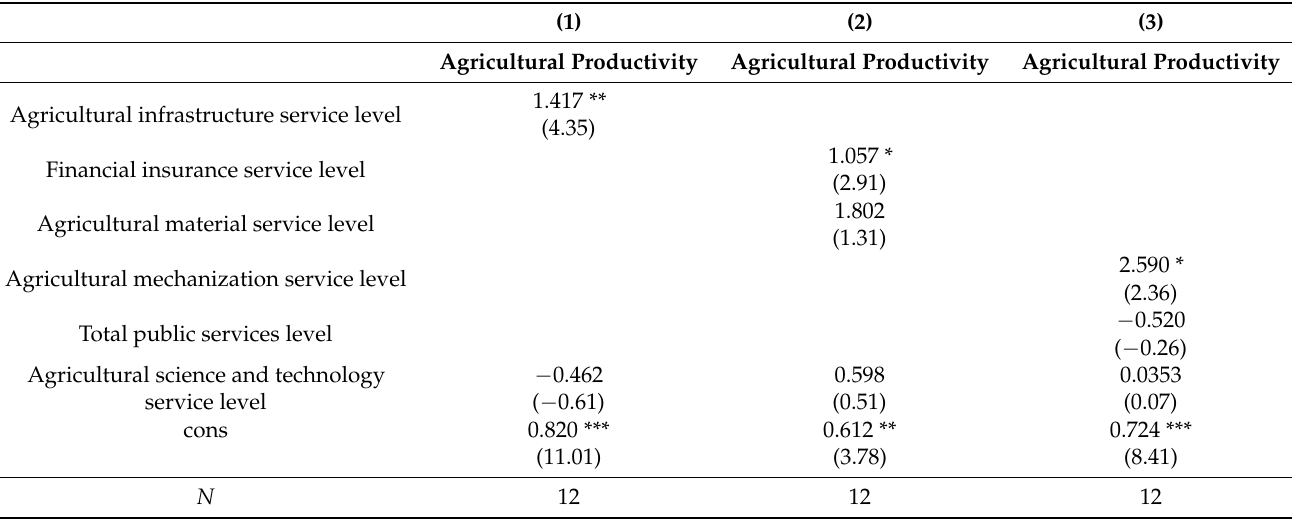
Table 5. Regression results for agricultural socialized services and agricultural production